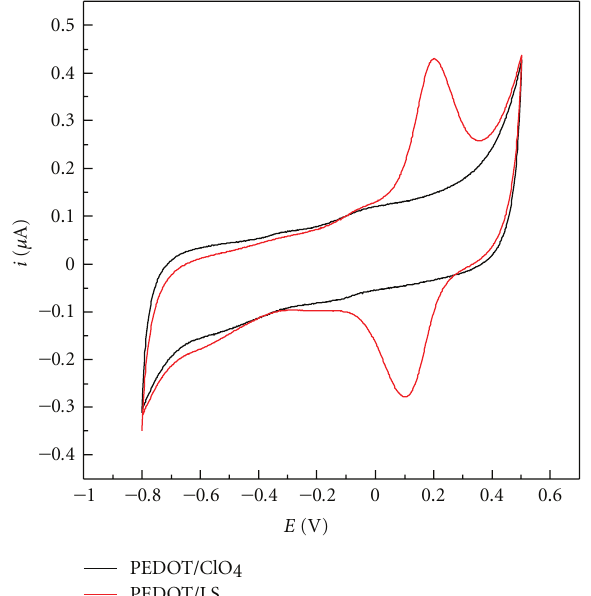
Figure 2: Comparison of cyclic voltammograms of PEDOT films electropolymerized in the absence (black line) and presence of LS (red line). LS concentration in the plating bath—1 mgcm − 3 . Scan rate—10 mVs − 1 . Electrolyte-phosphate bu ff er (pH 7.4).